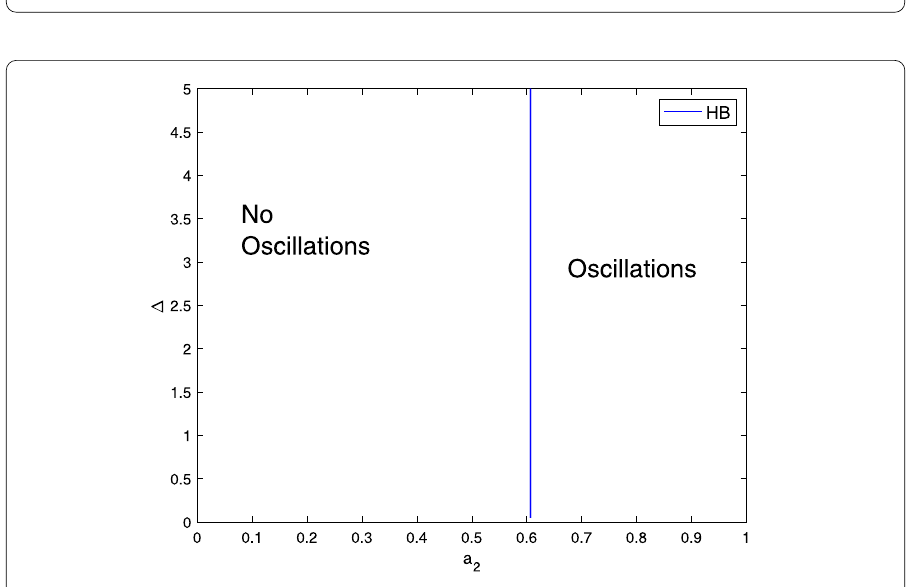
Figure 6 A two-parameter plot showing the role of a 2 and (cid:5) on generating limit cycle oscillations. Parameter values are similar to Fig.